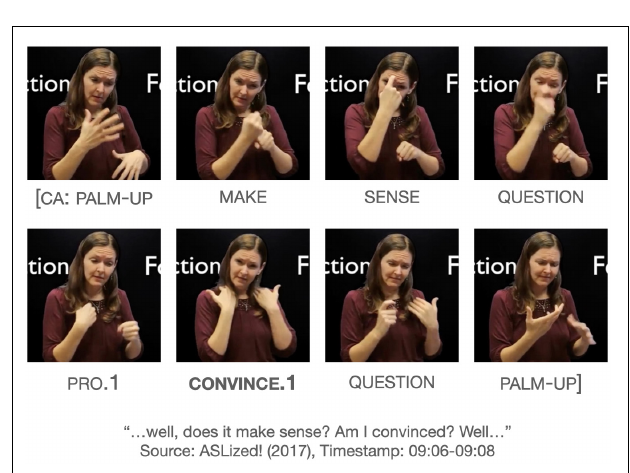
FIGURE 6 | Another example of CONVINCE .1 in a passive construction. Images produced with permission, source information available in the Supplementary Material